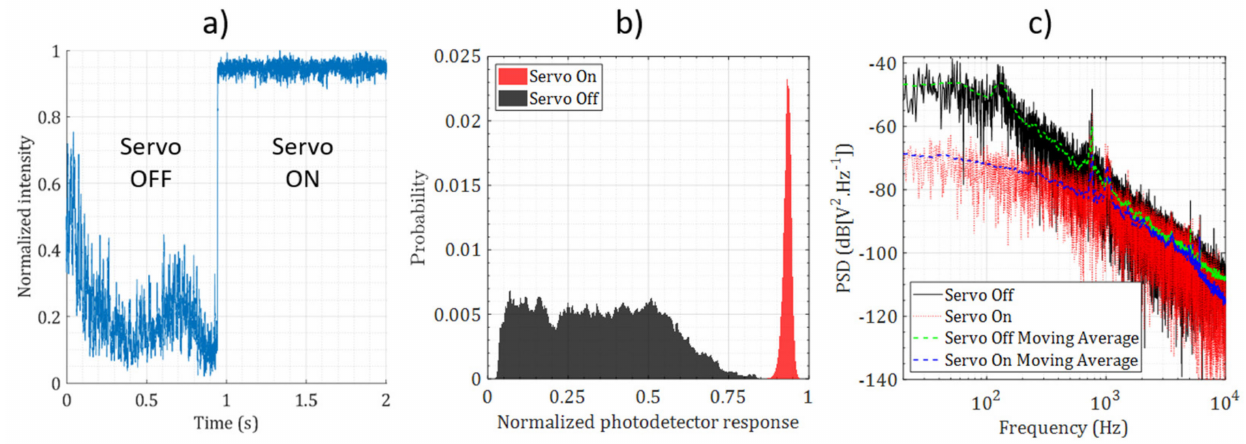
Figure 8. ( a ) Normalized evolution of the combined beam power detected by a photodiode located on the far field center when the NN servo is OFF then ON, ( b ) Normalized histogram of the combined laser power evolution according to time when the servo is OFF (black) then ON (red). ( c ) Power spectral density of the 7-fiber laser array when the NN servo is OFF (black) and ON (red) and their moving average (green and blue traces,